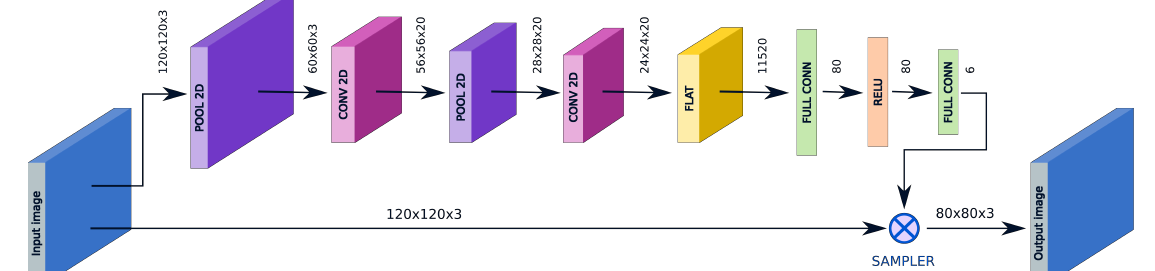
Figure 6. Structure of the STN component: an input image is processed by a shallow CNN-based localization network. The convolutional feature maps are then processed trough two fully connected layers that generate the six parameters of the affine transform. A grid generator (not represented) generates the corresponding sampling grid, that will be actually sampled by the sampler, producing an automatically aligned and cropped version of the